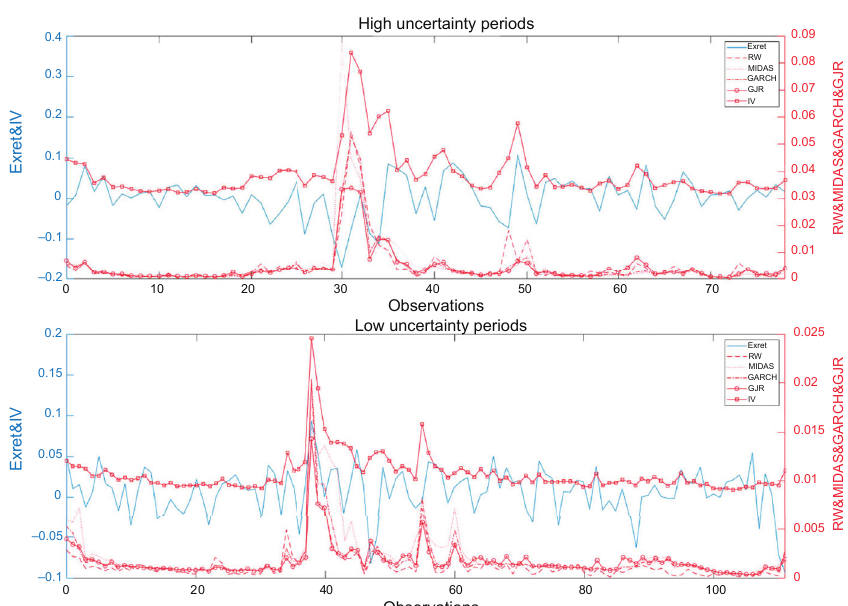
Figure 1. Time-series of monthly excess stock market returns, conditional variances and implied variance with